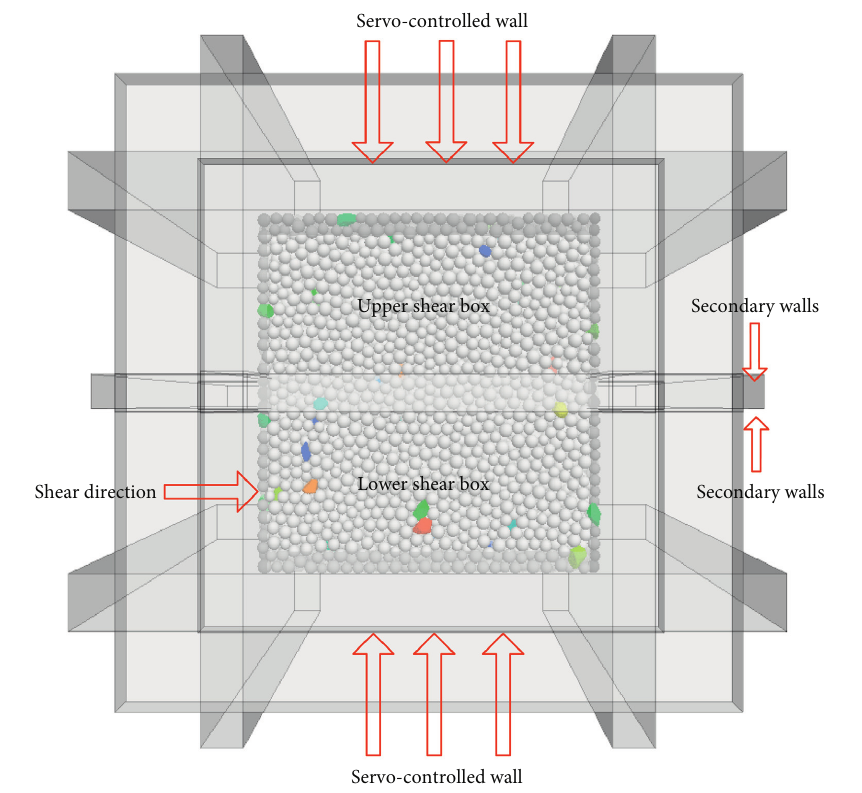
Figure 3: Numerical test shear